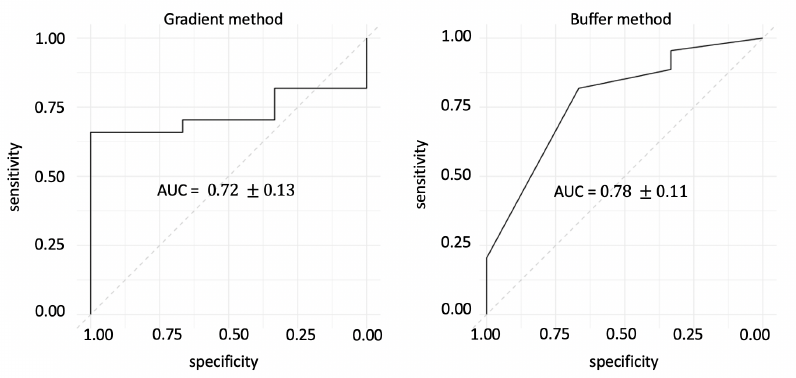
Figure 8. The classification performance in terms of Area Under the receiver operating characteristic Curve (AUC) for both gradient ( left ) and buffer ( right ) methods for the ascending orbit. Both the gradient and buffer methods performed better than chance with AUC = 0.72 ± 0.13 and AUC = 0.78 ± 0.11, respectively. The reported standard error was calculated with the Hanley formula [23]. At the operating points, the gradient method returned sensitivity 65.9% and specificity 100% while we obtained sensitivity 81.4% and specificity 66.7% for the buffer